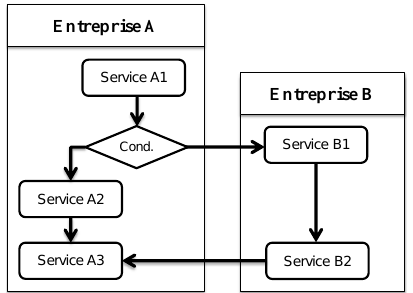
Figure 1. Illustration of SOC paradigm through outsourcing example.